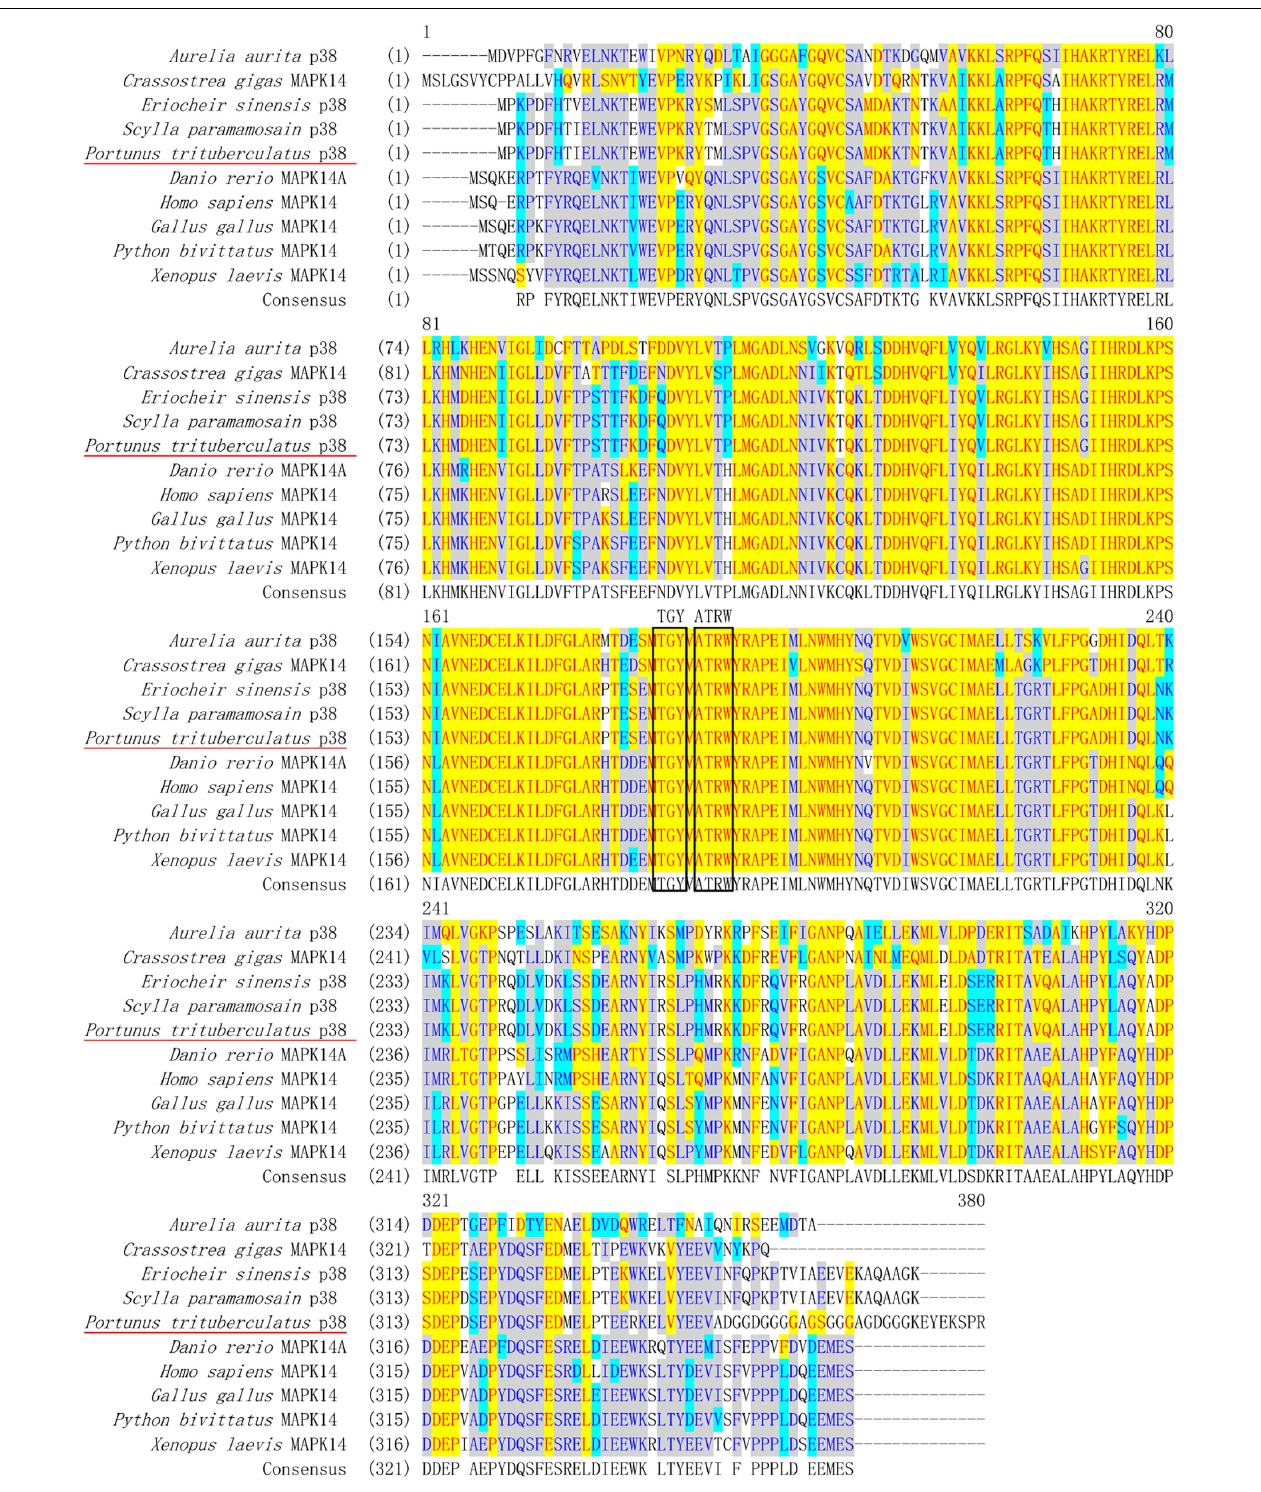
FIGURE 2 | Multiple alignment of PtP38 with P38s from other species. The conserved amino acid residues in these sequences are shown in yellow. The conserved phosphorylated TGY motifs and ATRW sites are indicated by a black box. PtP38 shares the highest identity with Scylla paramamosain (94%), followed by Eriocheir sinensis (93%). The homology to Gallus , Python bivittatus, and Pacific oyster Crassostrea gigas is 73%, to Homo sapiens , Xenopus laevis, and Danio rerio is 72%, and to Aurelia aurita is 63%.